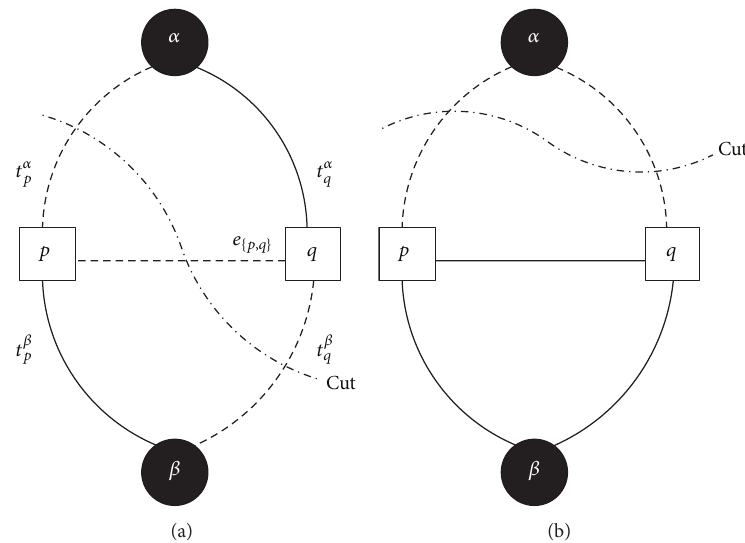
Figure 7: Two possible graph cuts result. 𝛼𝛽 are two labels and 𝑝𝑞 are pixels.